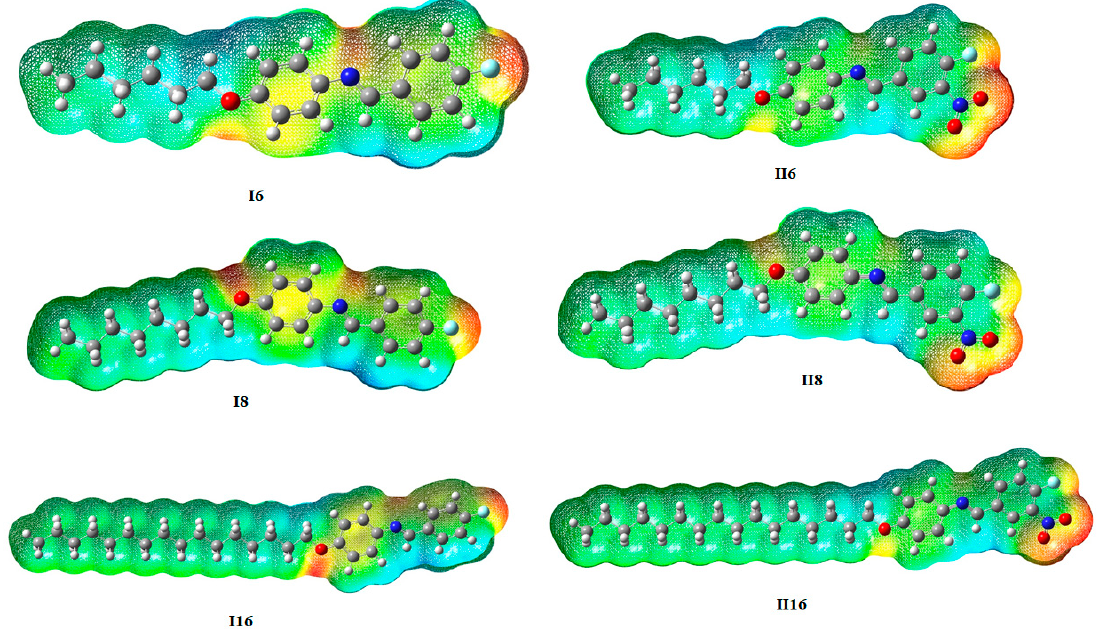
Figure 6. Molecular electrostatic potentials (MEP) of groups I n and II n .